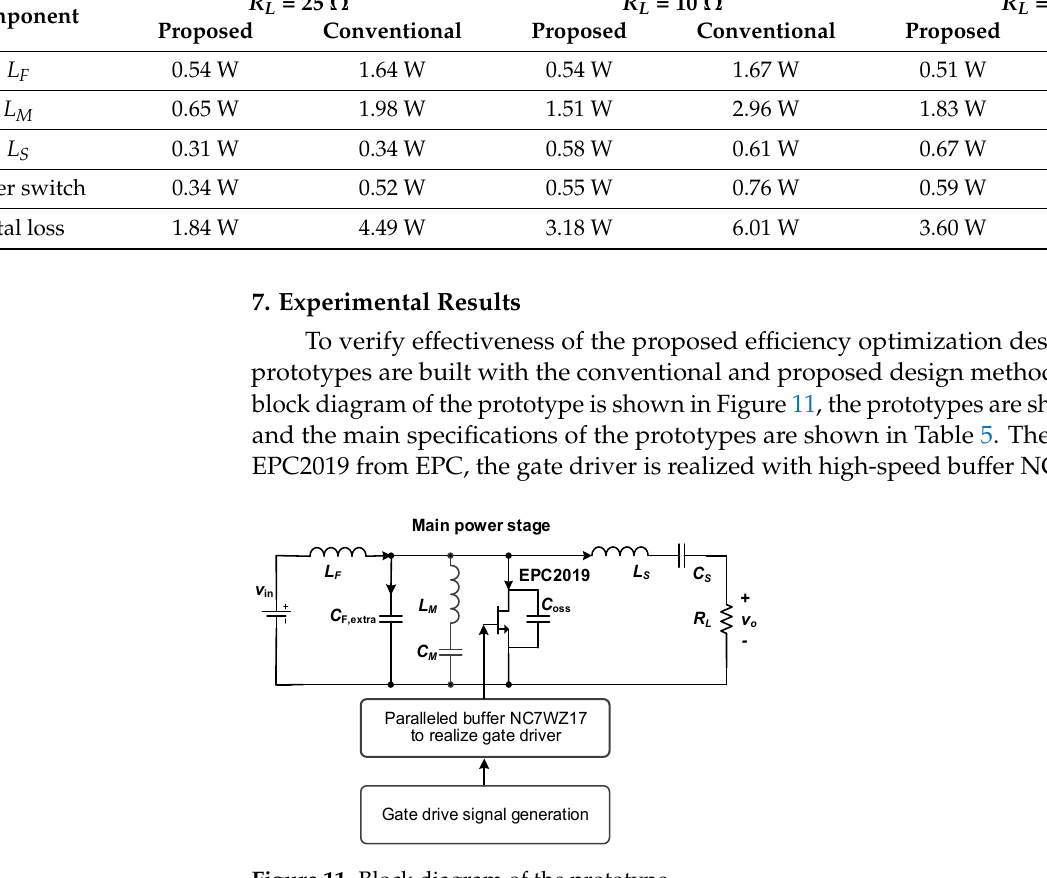
Figure 12. Class Ф 2 inverter prototypes with different design methods: ( a ) proposed method; ( b ) conventional design method.